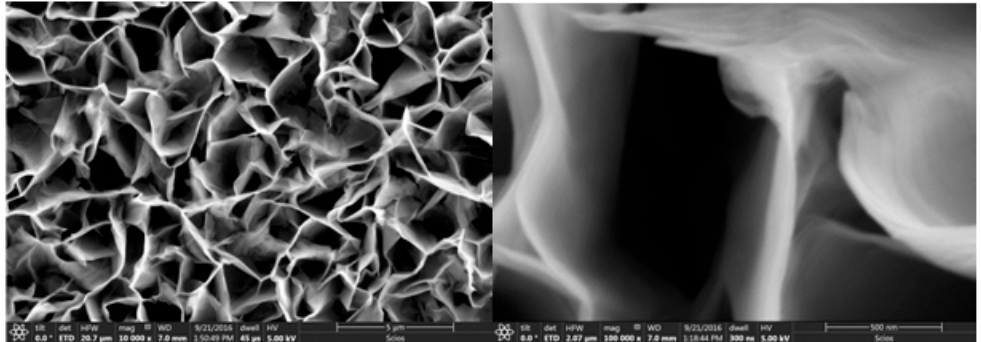
Figure 3. SEM micrographs of ZnO nanostructures hydrothermally grown on the anodized aluminum substrate.